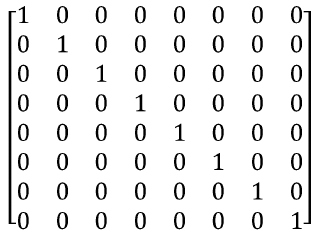
Figure 6. Identity matrix.